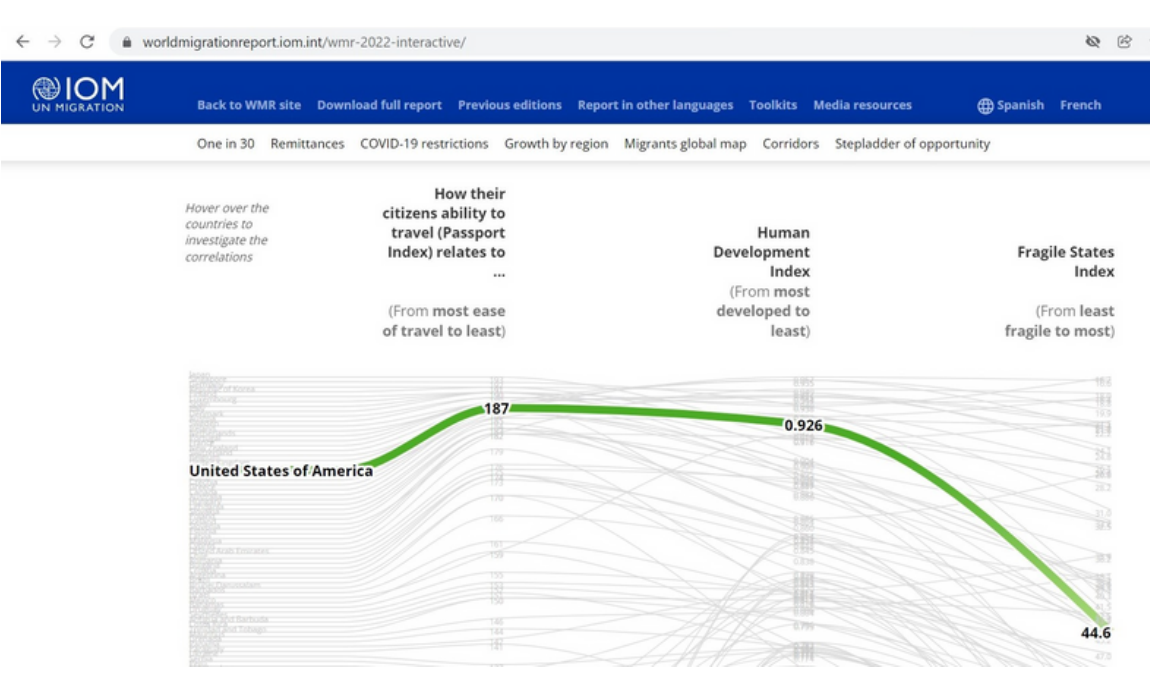
Figure 4. Static screenshot of the interactive platform. From IOM